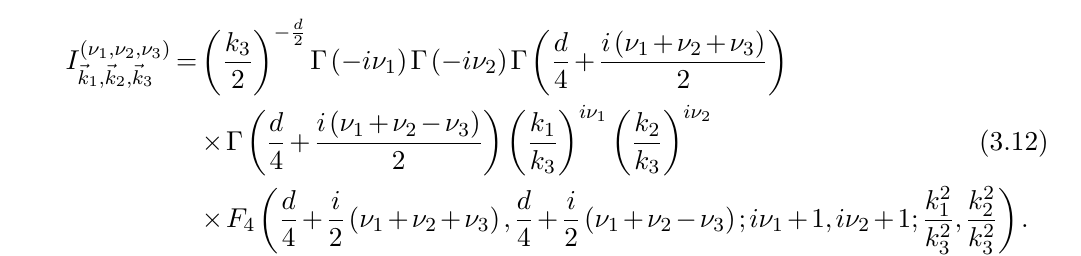
JHEP01(2020)090 (cid:0) d (cid:1) (cid:0) s 1 (cid:0) s 2 (cid:6) i(cid:23) 3 in 4 2